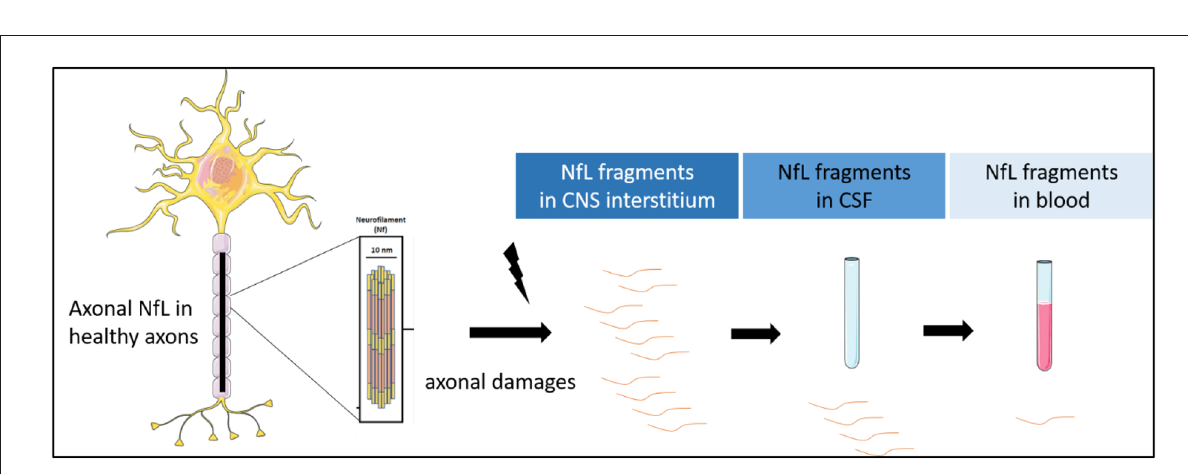
FIGURE2 NfL release after axonal damages. NfL are detectable in CSF and